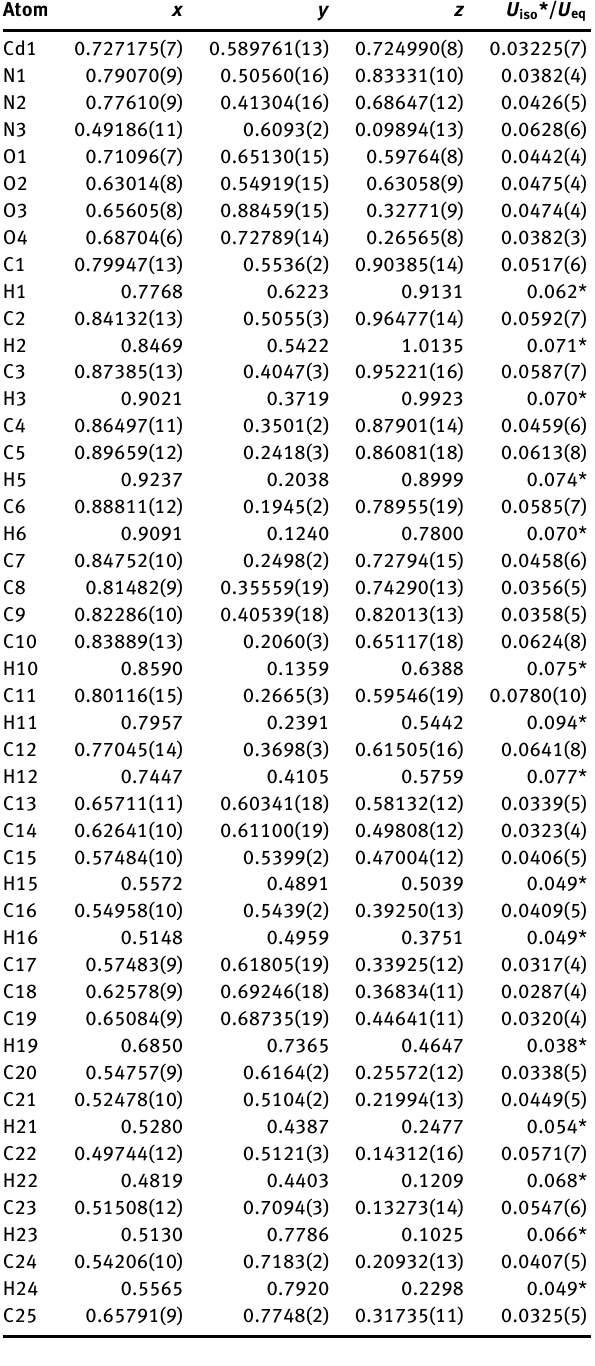
Table 2: Fractional atomic coordinates and isotropic or equivalent isotropic displacement parameters (Å 2